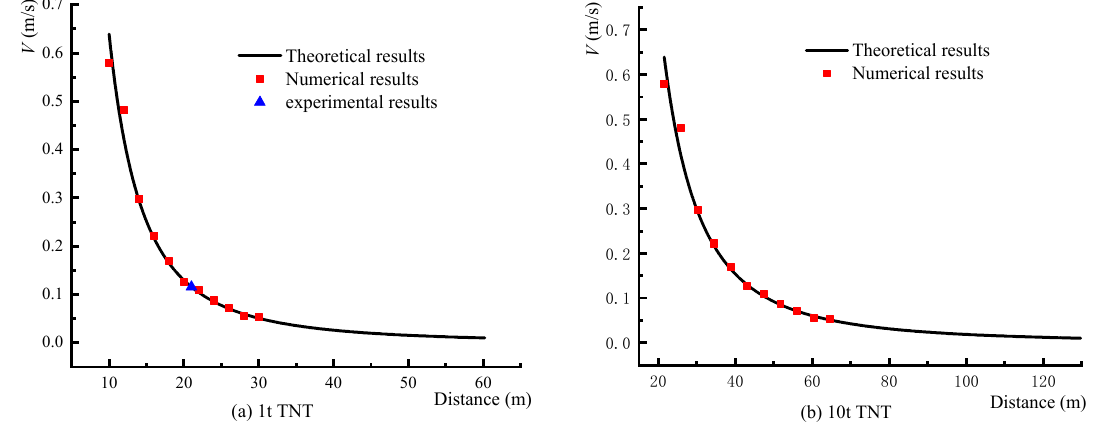
Figure 12. The relationship between the maximum particle vibration velocity and the propagation distance, ( a ) 1t TNT and ( b ) 10t TNT.